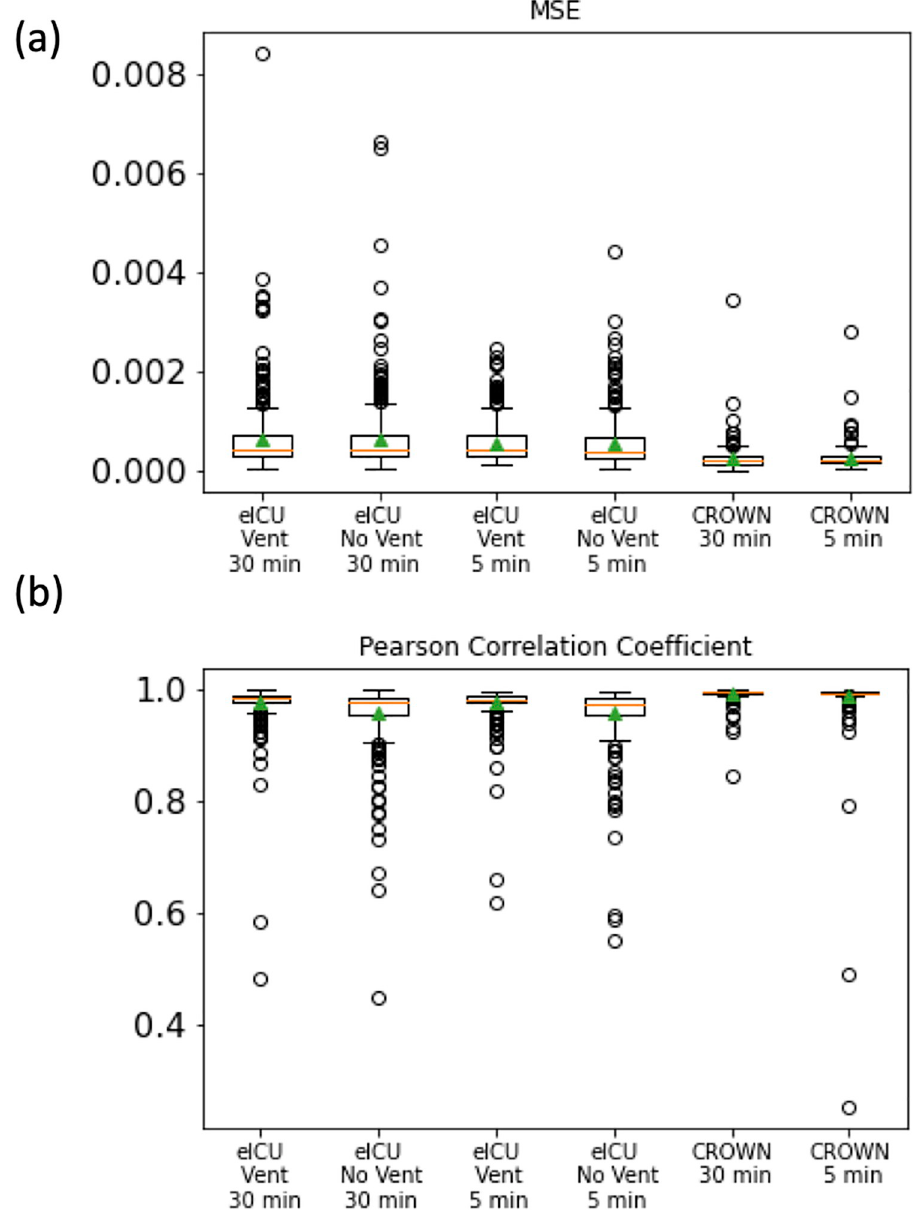
Fig 4. (a) Mean-Squared Error and (b) Pearson Correlation Coefficient for waveform predictions for eICU and JH-CROWN patients. In each box-and-whisker plot, the box extends from Q1 to Q3. The orange line represents the median value and the green triangle represents the mean value. The upper whisker extends to the highest value below Q3+1.5 � (Q3-Q1), and the lower whisker extends to the lowest value below Q1-1.5 � (Q3-Q1). Points beyond the whiskers are considered